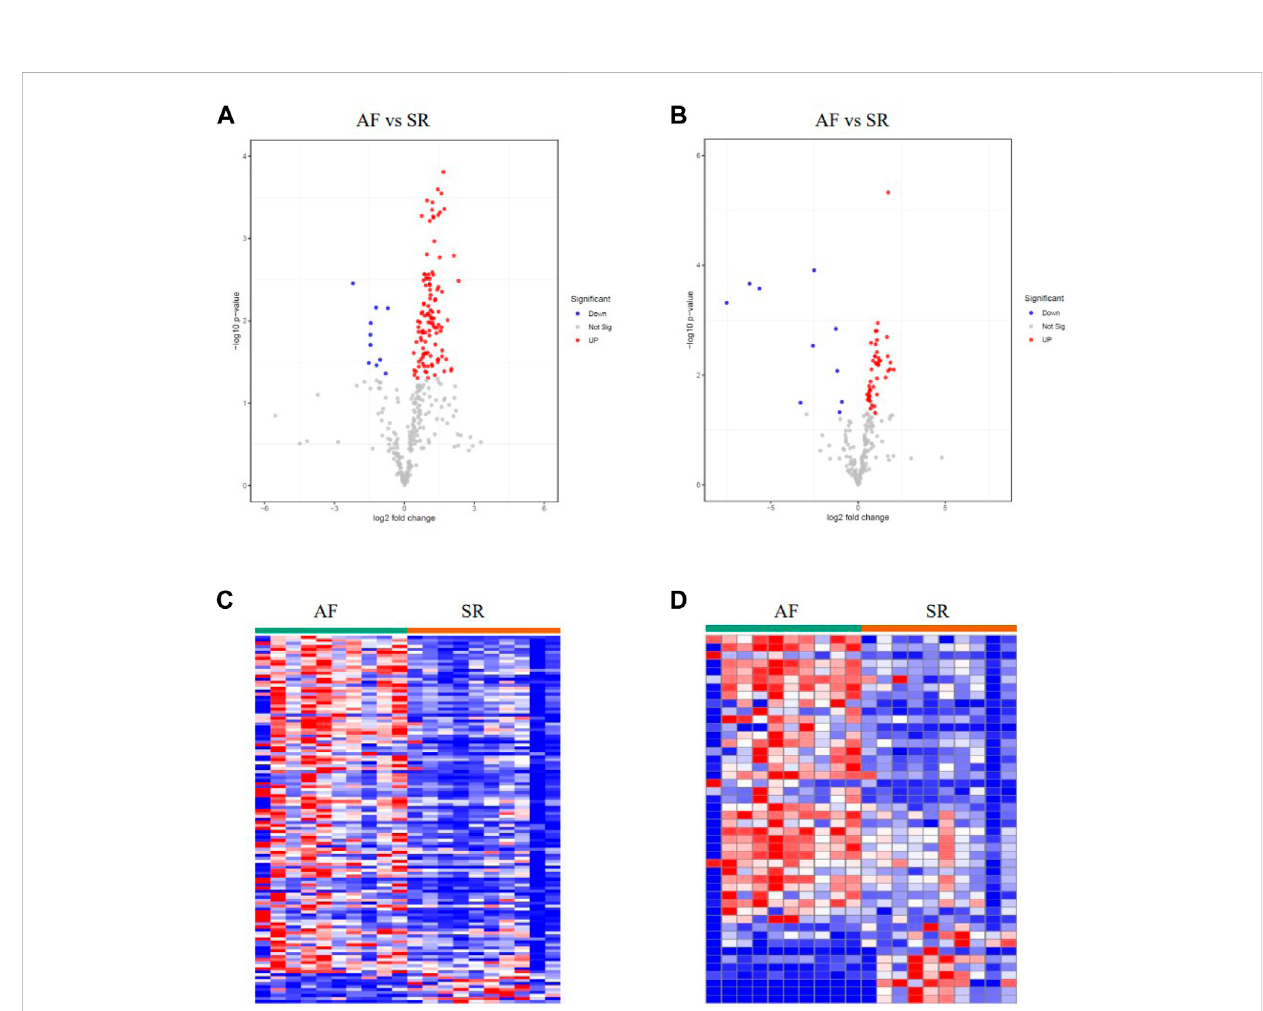
FIGURE 2 Metabolomic pro fi ling analysis of AF samples and SR samples. (A – B) Volcano plots of the differently expressed metabolites in positively- and negatively-ionized modes, respectively. (C – D) Heatmaps of the differently expressed metabolites in positively- and negatively-ionized modes,